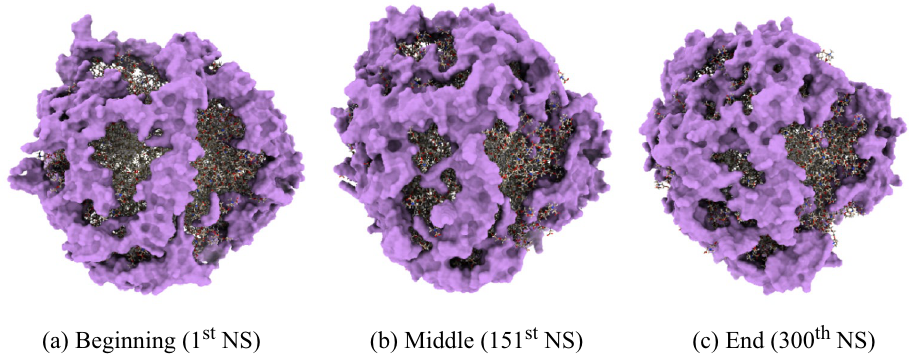
Figure 5. Simulation figure for a design containing the drug Panobinostat, generated using ChimeraX 55 . The purple portion depicts the drug molecules around the surface.